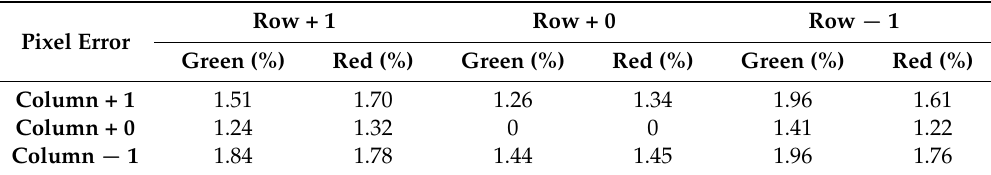
Table 10. The error generated by the registration.